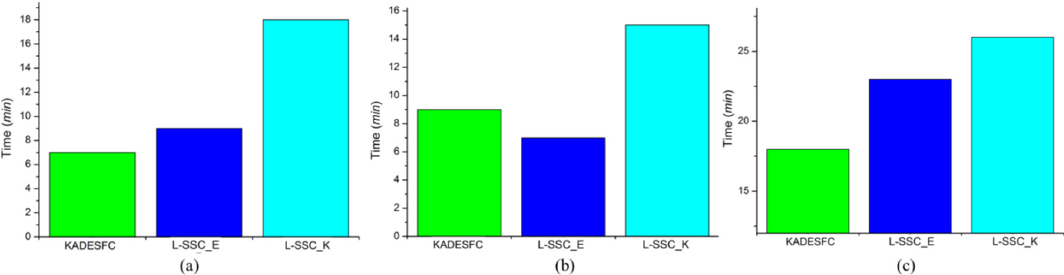
Figure 14. Comparison of computational time for ( a ) Wuhan TM; ( b ) Fancun IKONOS; and ( c ) Indian Pine AVIRIS.